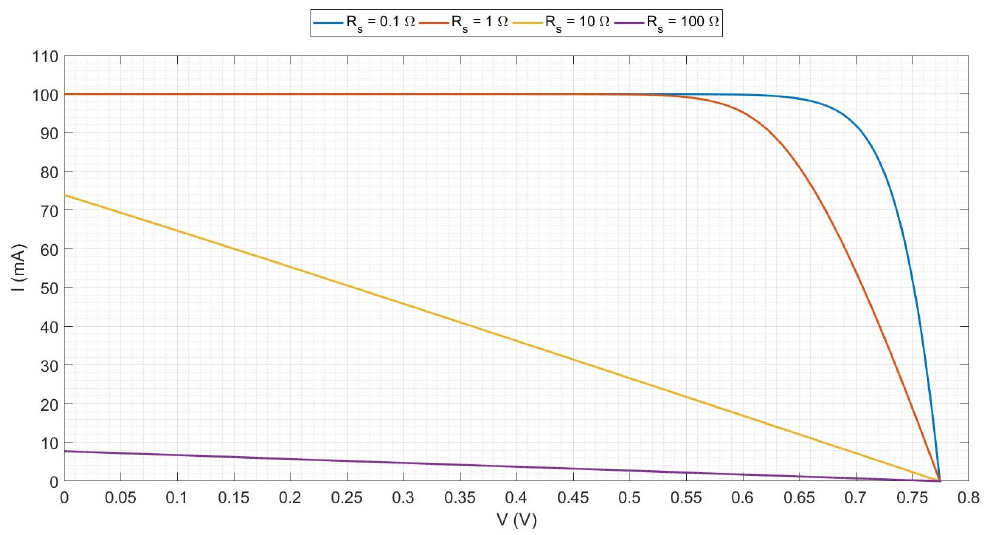
Figure 10. Example of I(V) curves for different values of R s : the effect of the series resistance on the current–voltage characteristic.